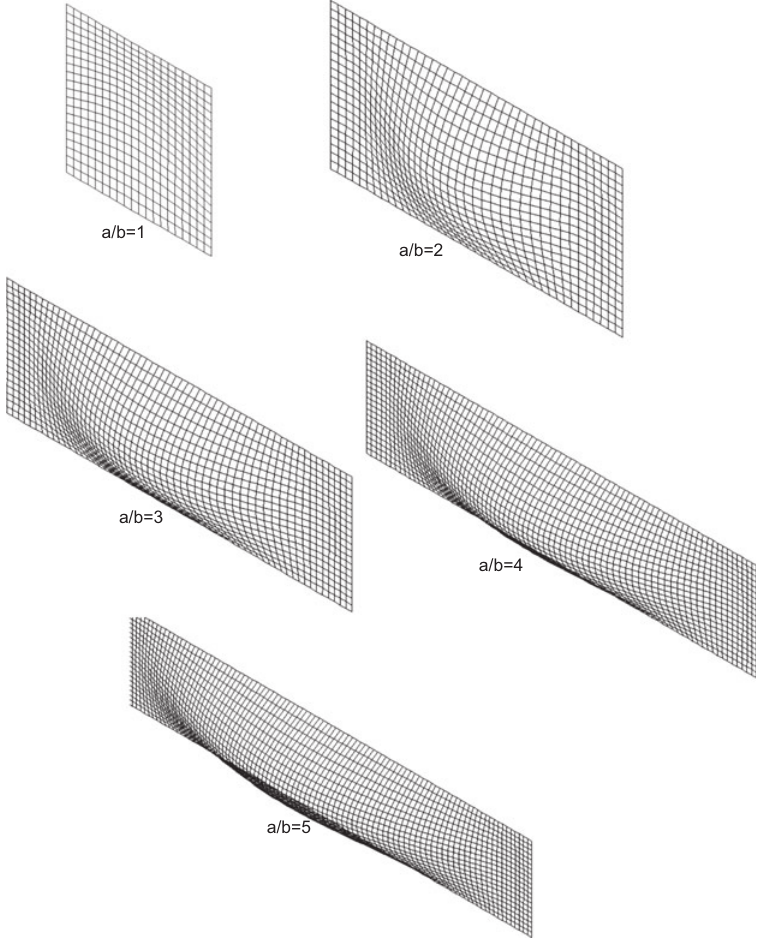
Figure 9 Mode shapes for C23 combination for simply supported laminated plates.